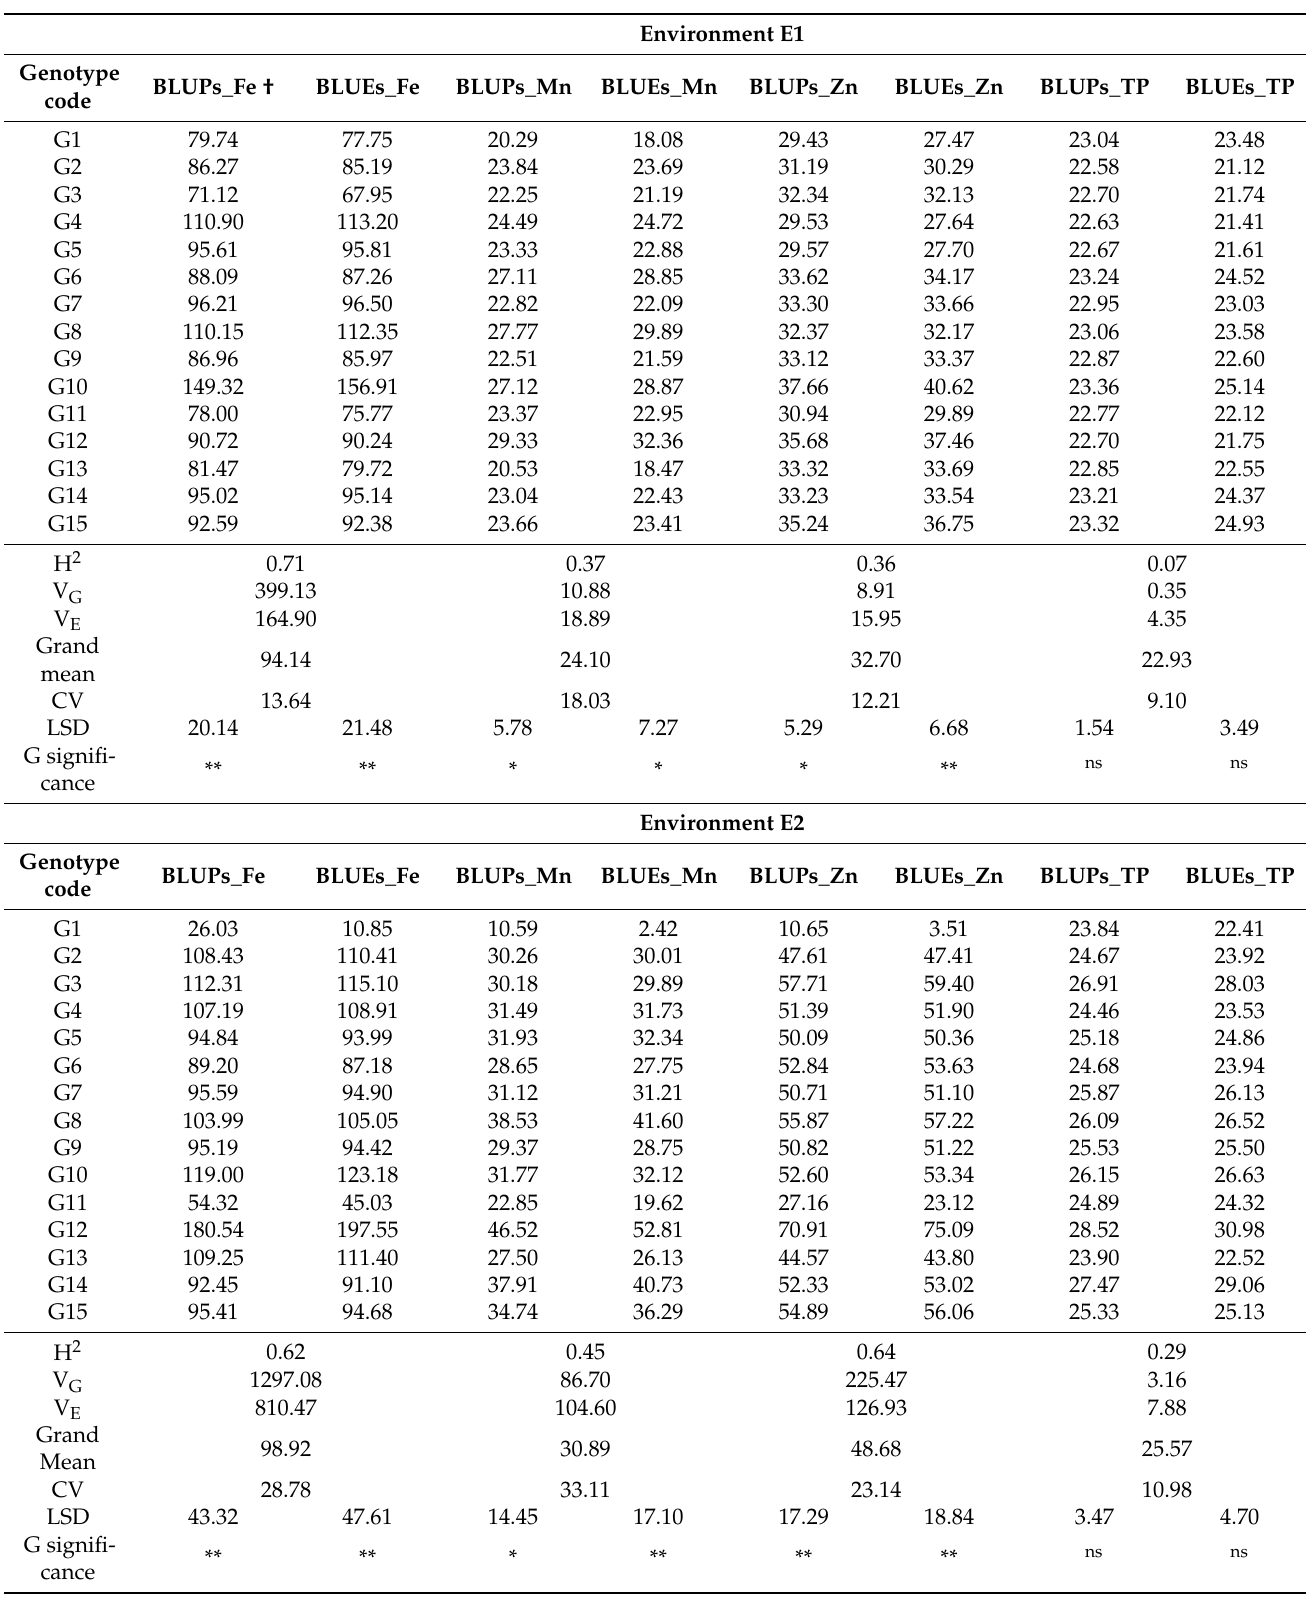
Table 6. Best linear and unbiased predictions (BLUPs) and best linear and unbiased estimates (BLUEs) of 15 cowpea genotypes evaluated for nutrient content among six environments in South